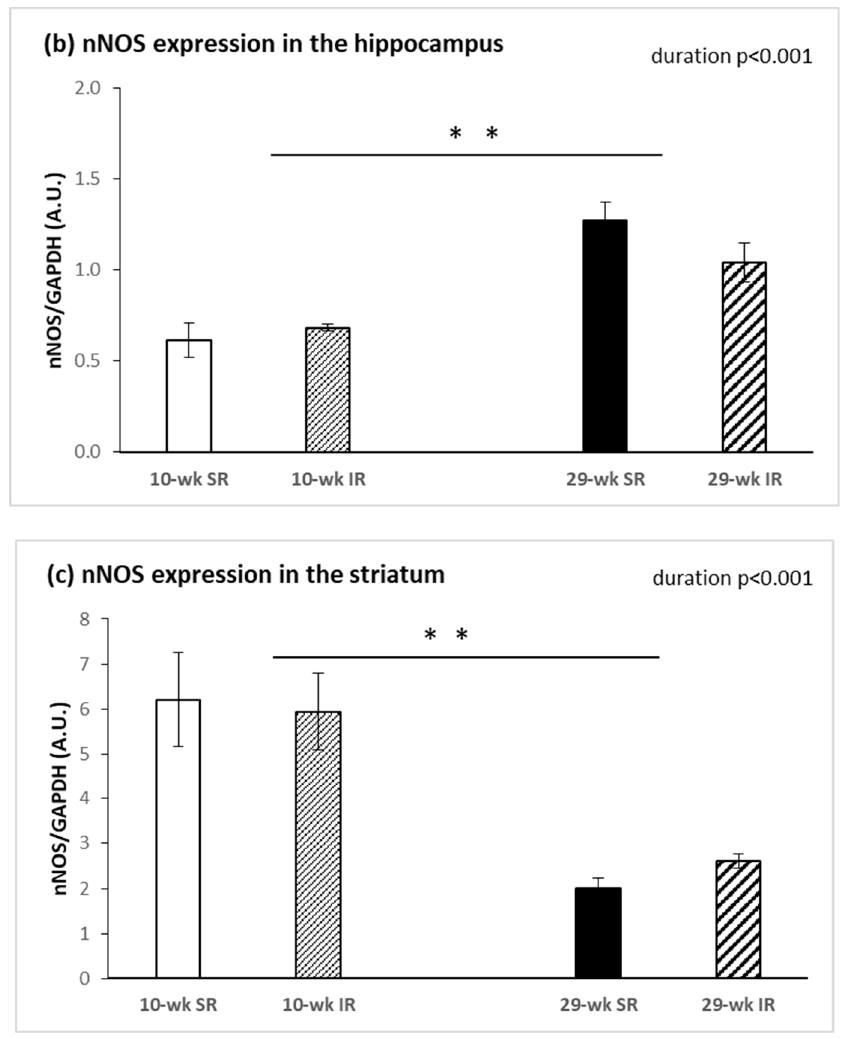
Figure 3. Effects of isolation rearing conditions on protein expression of nNOS in the cerebellum ( a ), hippocampus ( b ), and striatum ( c ). 10–wk SR, 10 week socially reared SD rats; 10–wk IR, 10 week isolation reared SD rats; 29–wk SR, 29 week socially reared SD rats; 29–wk IR, 29 week isolation reared SD rats; nNOS, neuronal nitric oxide synthase; iNOS, inducible nitric oxide synthase; SD, Sprague Dawley; GAPDH, glyceraldehyde 3–phosphate dehydrogenase; A.U., arbitrary units. Data are expressed as the mean ± SEM. Statistical significance as revealed by two-way ANOVA with subsequent Sidak post-hoc test when appropriate: ** p < 0.001.